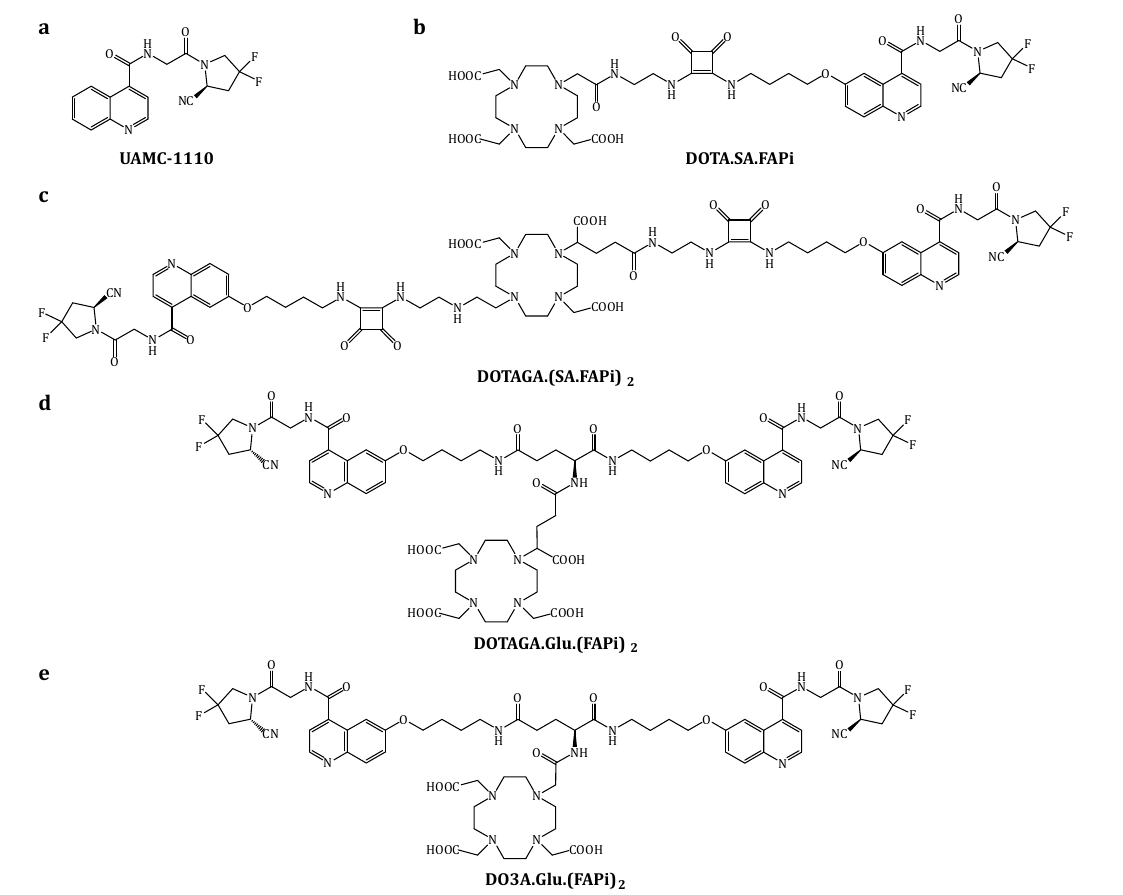
Figure 1. Structures of the original FAP inhibitor UAMC ‐ 1110 ( a ), the FAPi ‐ based monomer DOTA.SA.FAPi ( b ), the first ‐ generation linear FAPi dimer DOTAGA.(SA.FAPi) 2 ( c ) and the second ‐ generation FAPi dimers DOTAGA.Glu.(FAPi) 2 ( d ) and DO3A.Glu.(FAPi) 2 ( e ).